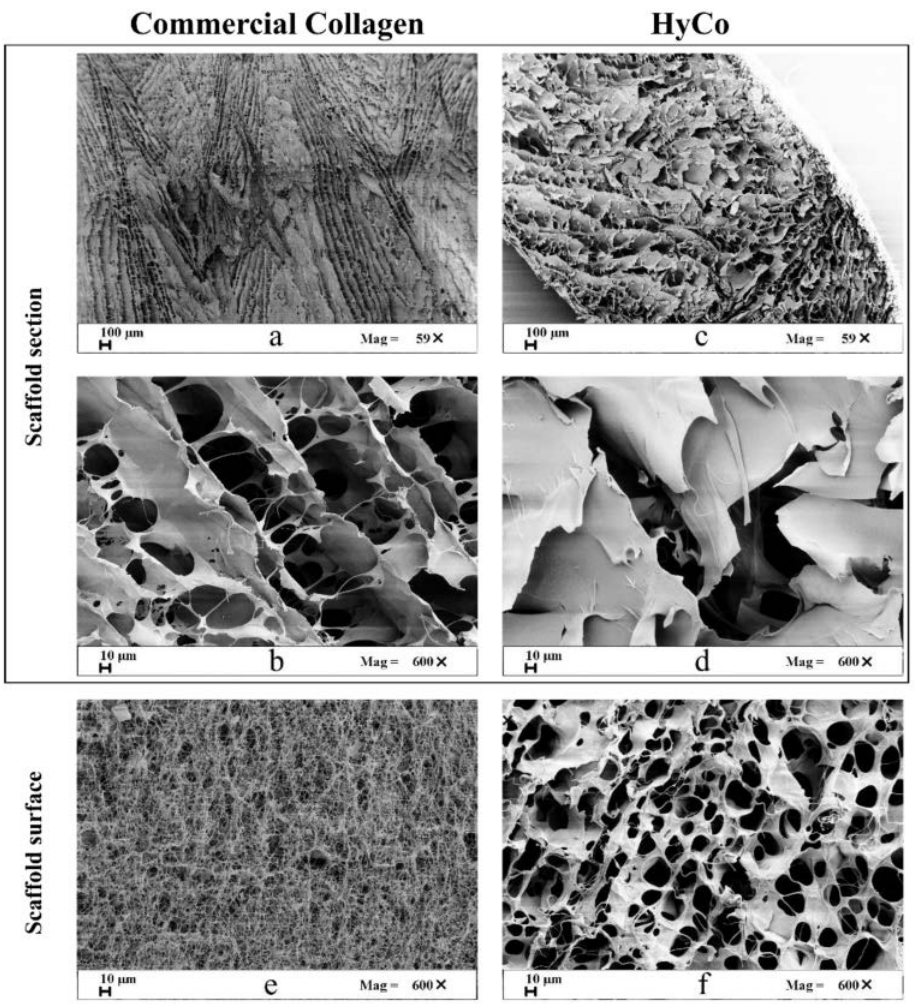
Figure 3. Comparison between SEM images of commercial equine type I collagen scaffold and HyCo. From the micrographs a different porosity and internal morphological organization of section and surface between commercial collagen ( a , b , e ) scaffold and HyCo one ( c , d , f ) is evident; however, both showed open and interconnected